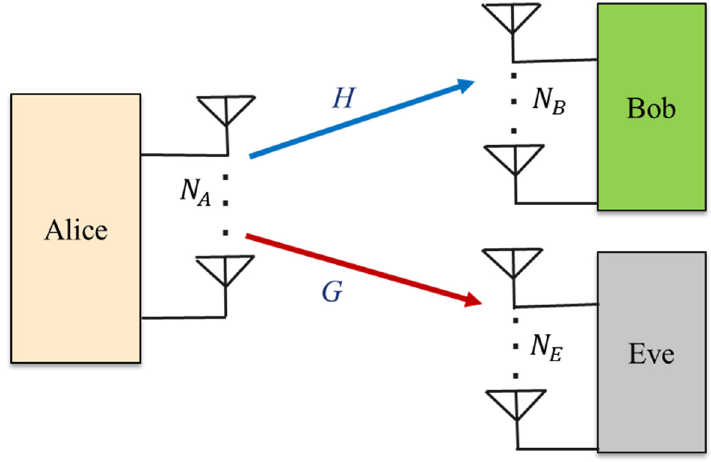
Figure 2. A system model for a MIMO wiretap